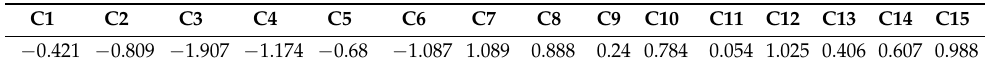
Table 7. The difference of rows and columns (D − R).